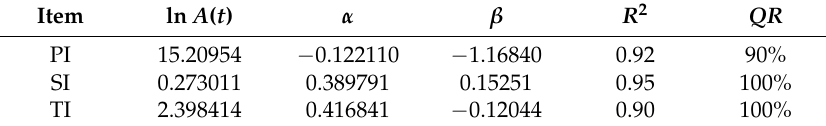
Table 4. Parameters obtained by CD function.